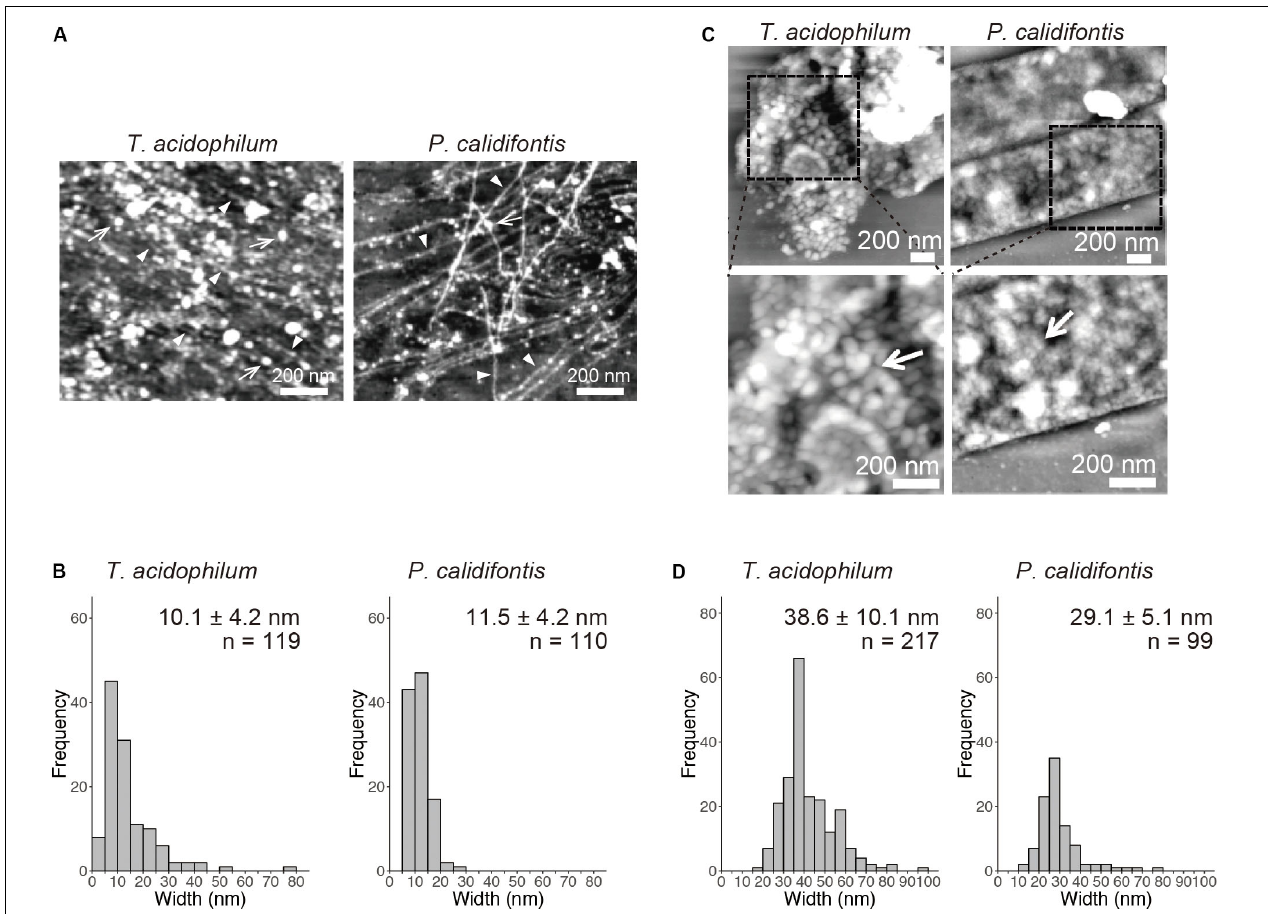
FIGURE 2 | Structural details of genomic materials from T. acidophilum and P. calidifontis after on-substrate lysis visualized with atomic force microscopy (AFM). (A,B) Extensively released chromosome fibers of log-phase cells. (A) AFM images of the released genomic materials show relatively thin fibers (arrow heads) and globular structures (arrows). (B) Histograms indicate the diameters of the released fiber structures indicated by arrow heads in (A) . (C,D) Compact chromosome of stationary phase cells. (C) AFM images of the lysed cells. Boxed areas in the upper panels were shown in detail in the lower panels. Globular structures (arrows) were observed more frequently than in the log phase. (D) Histograms indicate the diameters of the globular structures. Scale bars: 200